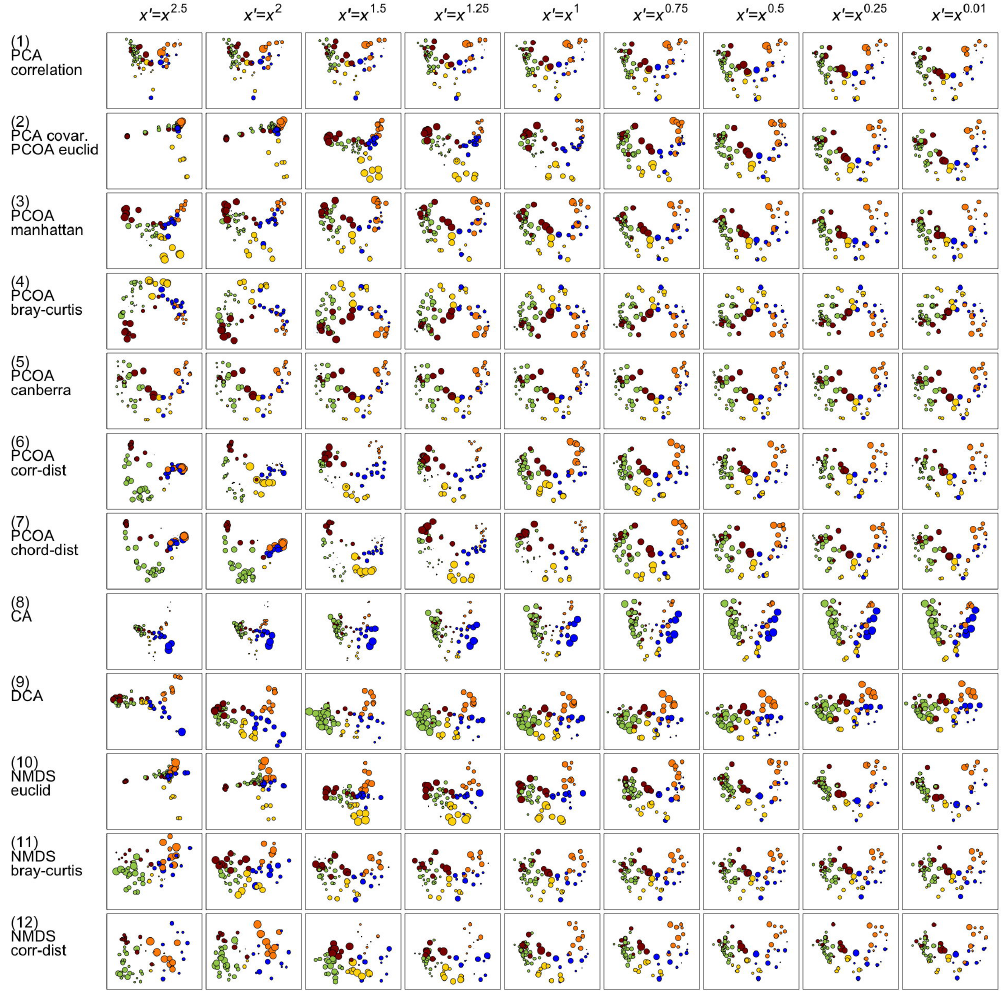
Figure 1. The panel of ordinations obtained with the data frame “sveg”, n = 63. Variation of ordination in vertical direction is caused by changing methods and in the horizontal direction by alternative data transformations. The classification of data points (colours) serves as an ease of visual comparison only, and has no effect on the results. Table 2. The efficiency of ordinations of “sveg” data (Figure 1) measured by fitting trend surfaces of site factor “pH.peat” to the first two ordination axes. The elements of the table are Akaike’s criterion (AIC) values expressing residual deviations with a correction for degrees of freedom [27]. Extensions in the method names signify: “cor” for correlation-based, “cov” for covariance-based, “m” for using